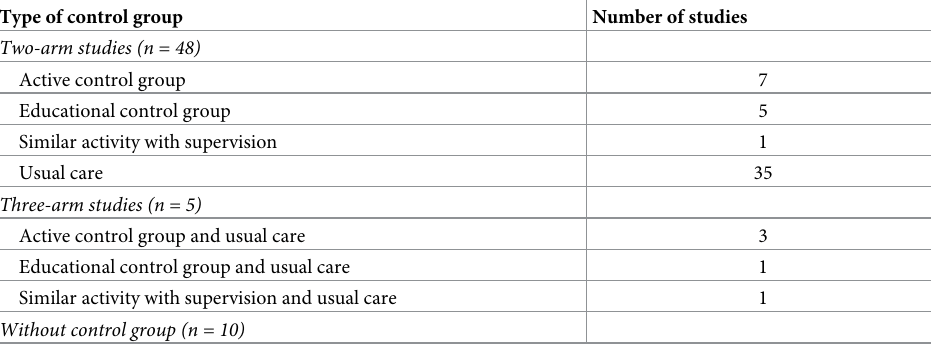
Table 2. Included control groups.